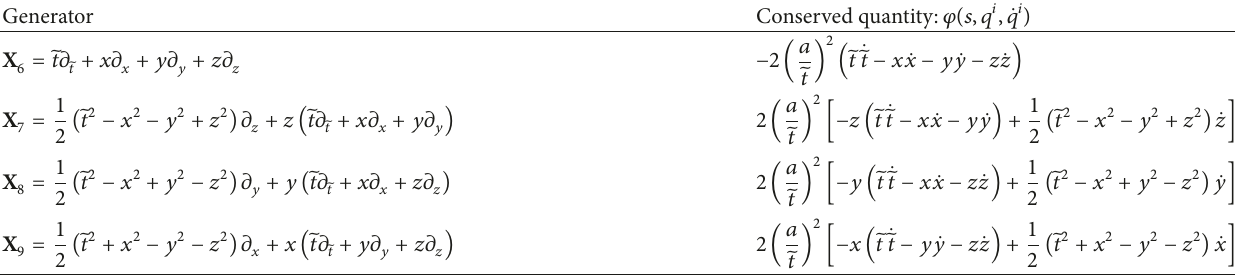
Table 3: Conserved quantities corresponding to each Noether symmetry.